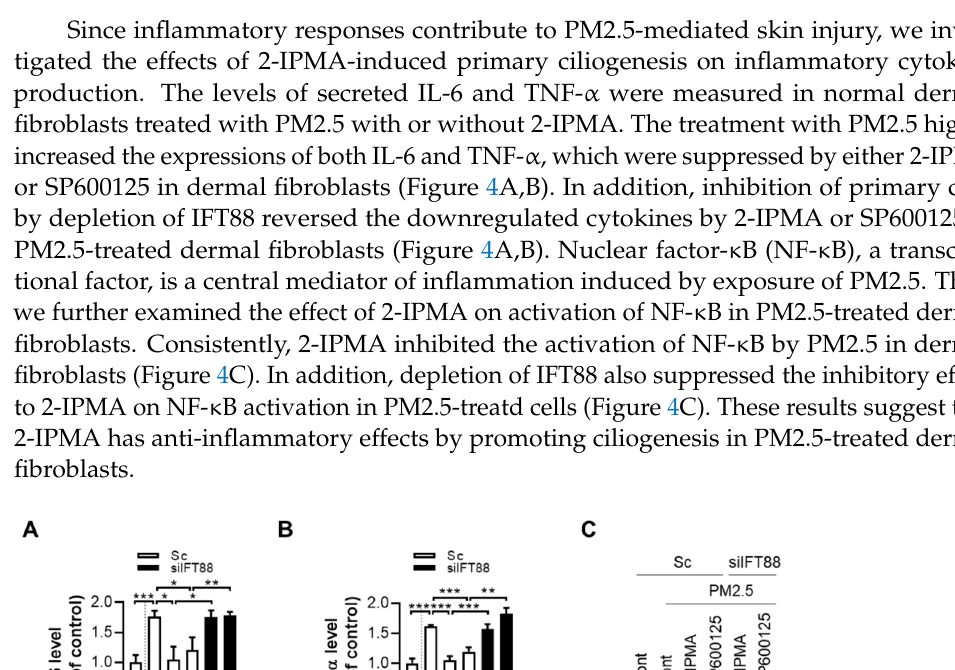
Figure 3. 2-IPMA inhibits JNK activation by PM2.5 in normal dermal fibroblasts. ( A , B ) Normal dermal fibroblasts were treated with PM2.5 (50 µ g/mL) with either 2-IPMA (100 µ M) or SP600125 (10 µ M) with 2-IPMA for 24 h. Then, the cells were harvested and analyzed by Western blotting with indicated antibodies ( A ). The relative expression of p-JNK verses JNK was analyzed using densitometry with the blots ( B ) ( ± SEM, n = 3, * p < 0.05). ( C , D ) Normal dermal fibroblasts were exposed to PM2.5 (50 µ g/mL) with either 2-IPMA (100 µ M) or SP600125 (10 µ M) for 24 h. Then, the cells were stained with ARL13B antibody (green) and Hoechst dye (blue) ( C ). Both ciliated cells and cilium length of the cells were measured ( D ). Data are presented as the mean ± SEM ( n = 100, * p < 0.05, ** p < 0.01). Scale bar: 10 µ m.